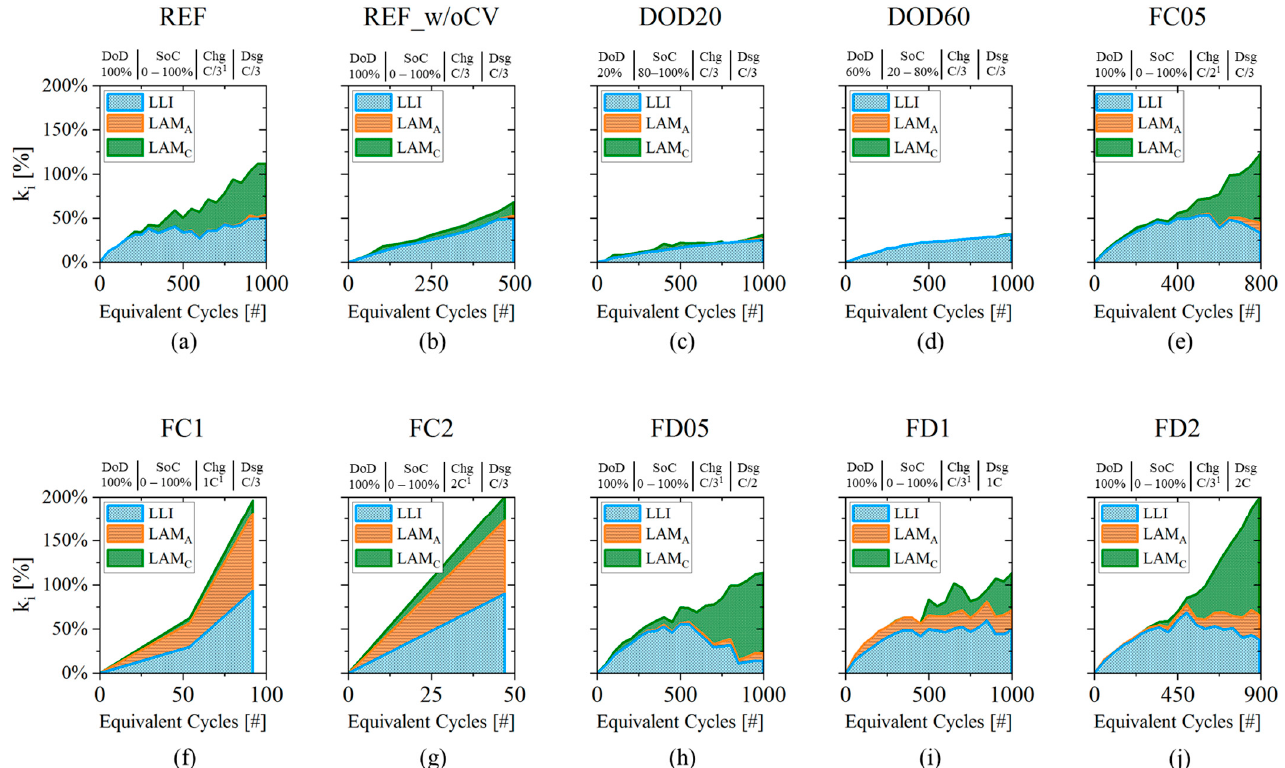
Figure 8. ( a–j ) Evolution of the three DMs indicators ( LLI , LAM A and LAM C ) for the cells under investigations. Details about testing protocols are given in plot titles: (i) DoD: Depth of Discharge;